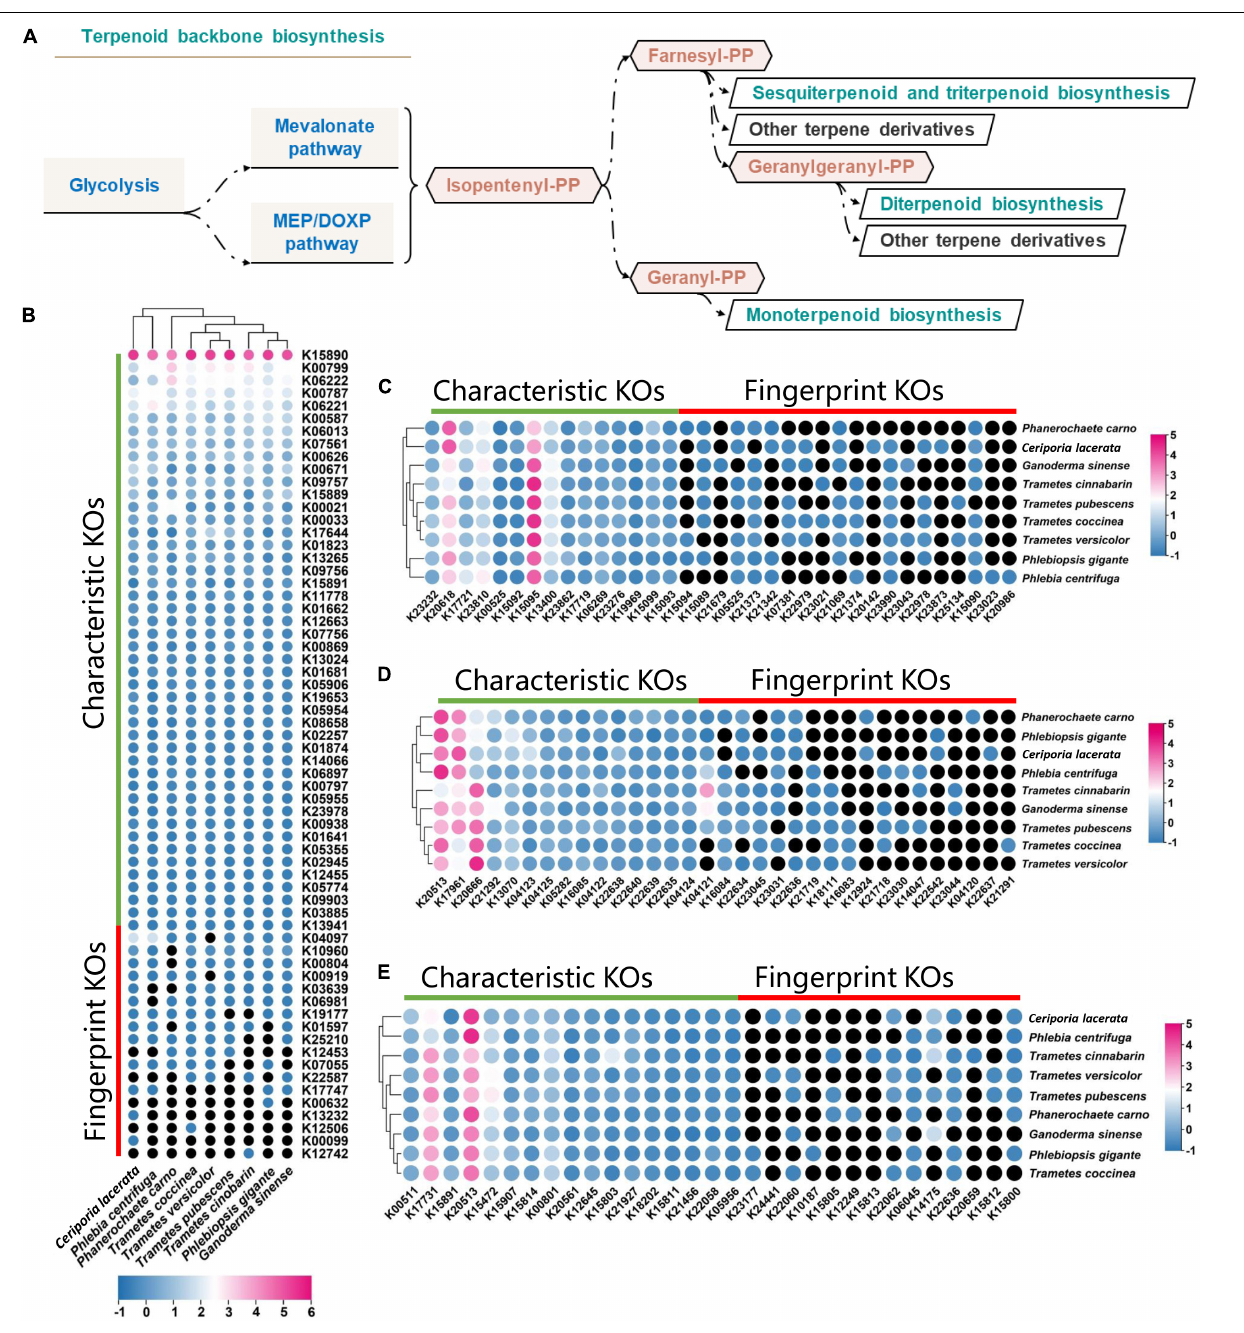
FIGURE 5 | Identification of terpenoid biosynthesis pathways in the Ceriporia lacerata genome. (A) Sketch of the biosynthesis pathways. (B) Annotation of the terpenoid backbone biosynthesis pathway (KEGG pathway map00900); (C) Annotation of the monoterpenoid biosynthesis pathway (map00909); (D) Annotation of the sesquiterpenoid and triterpenoid biosynthesis pathway (map00904); (E) Annotation of the diterpenoid biosynthesis pathway (map00902). The Enzyme Commission (EC) numbers for each pathway were converted into KO identifiers. The gene counts of each KO term are normalized by the Z-score method and increasing from blue to red in the color bar, while the missing KOs are indicated by black circles. More information is supplied in Supplementary Tables 3–6